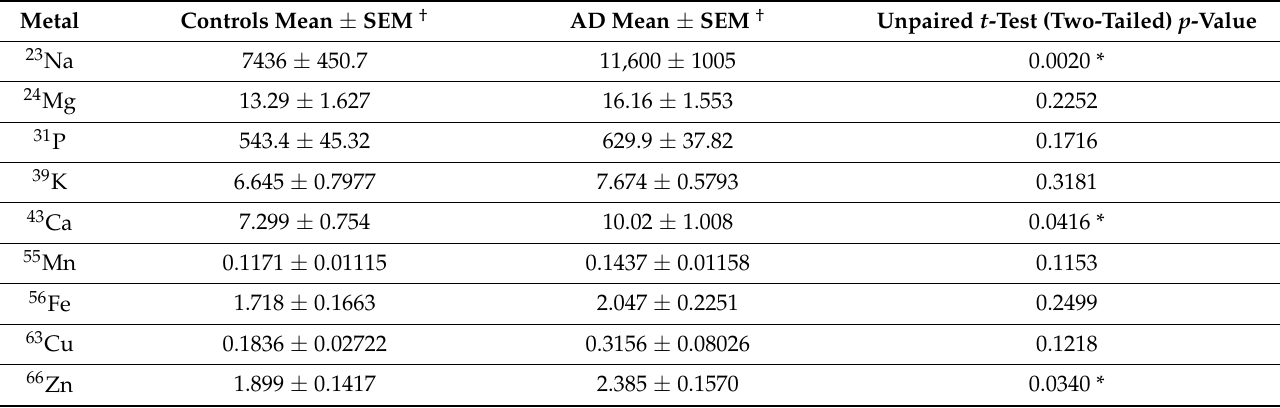
Table 3. The elemental content of Na, Mg, P, K, Ca, Mn, Fe, Cu and Zn in Alzheimer’s disease (AD) and control olfactory mucosa (OM) cells measured by inductively coupled plasma mass spectrometry